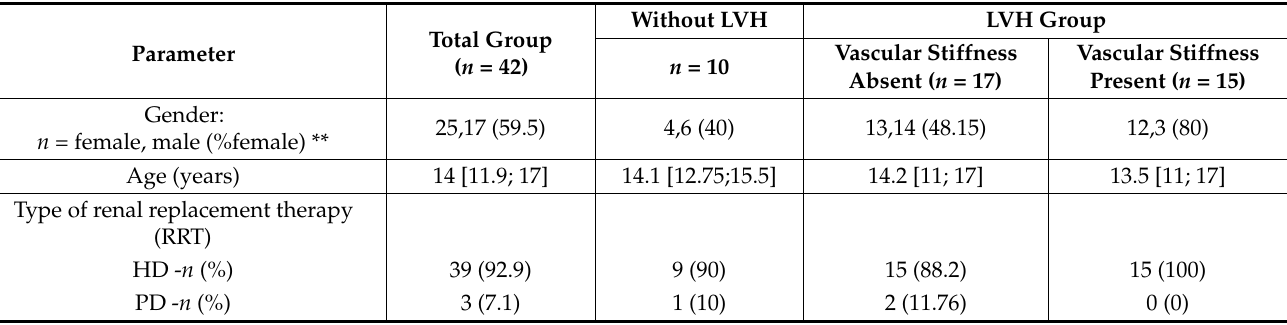
Table 1. Anthropometric, clinical, and echocardiographic data in the patients included in the study group, in children without LVH and group with LVH (with vascular stiffness and without vascular stiffness). Abbreviations: ** p ≤ 0.01, *** p ≤ 0.001. Data are expressed as (mean ± SD and 95% confidence interval) and n -number of patients (percentage).